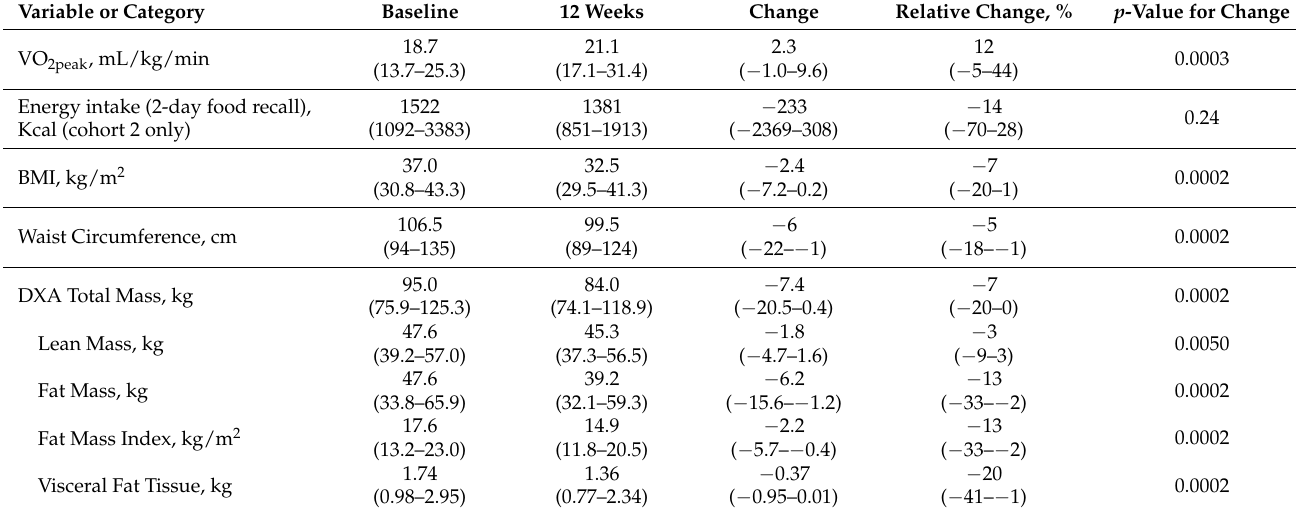
Table 3. Changes in V0 2peak , energy intake, anthropomorphic, and body composition (DXA) parameters, restricted to 18 breast cancer survivors completing the 12-week weight-loss intervention which included twice weekly personal trainer sessions. Median (range) values. p -values from Wilcoxon signed rank test, 2-